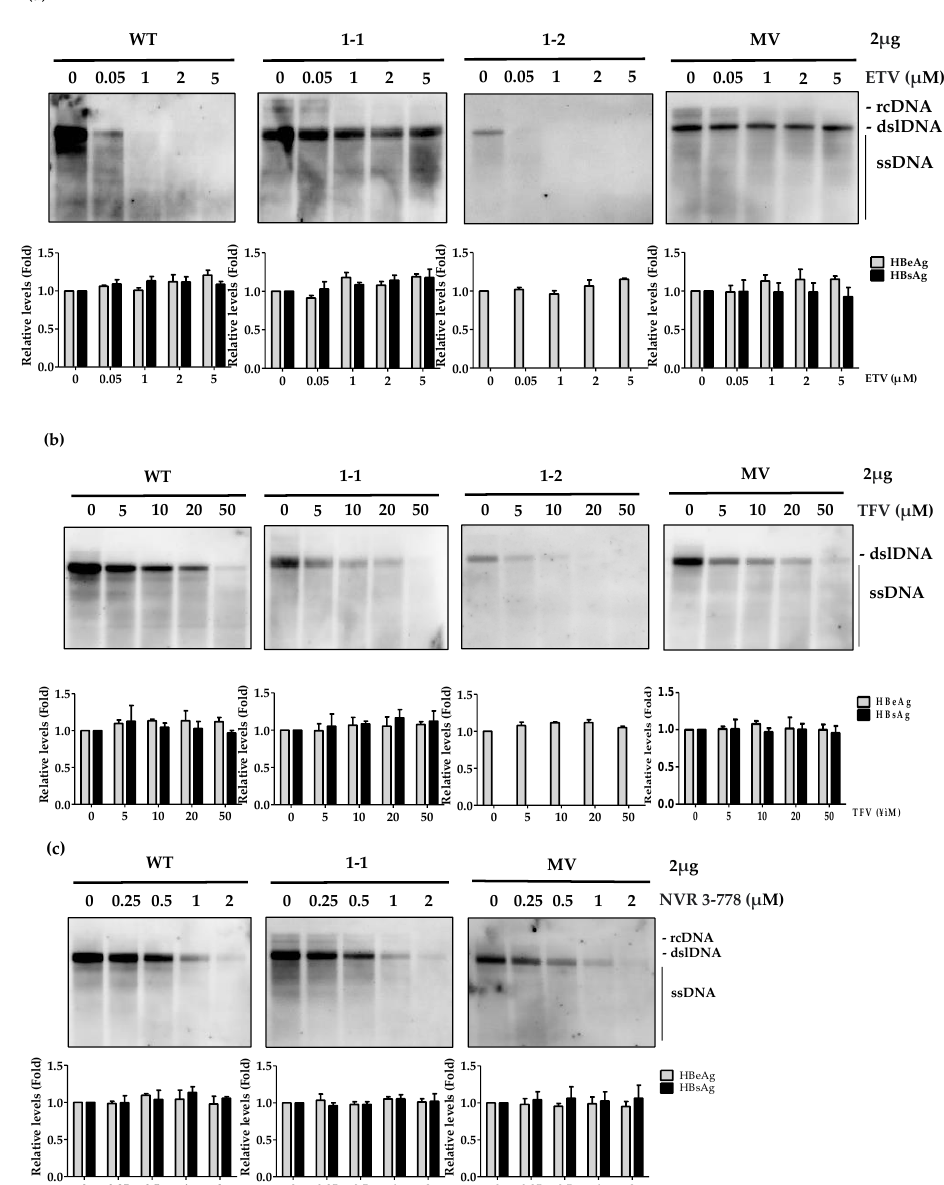
Figure 4. Susceptibility of BFV-resistant mutants to other antiviral drugs. ( a , b ) The in vitro drug susceptibility assay of patient-derived (1-1 and 1-2) and artificial MV clones was performed after treatment with ETV or TFV. After transfection with 2 µg of the indicated HBV 1.2mer mutants into Huh7 cells were treated with indicated antiviral agents (ETV or TFV) for 4 days. HBV replicative capacity was analyzed using Southern blot and detected with a DIG-labeled probe. The secreted HBV antigen levels (HBeAg, HBsAg) were analyzed by ELISA. ( c ) The drug susceptibility assay of patient-derived and artificial MV clones was performed after treatment with capsid assembly inhibitor, NVR 3-778. After transfection with indicated HBV 1.2 mer mutants into Huh7, cells were treated with NVR 3-778 for 4 days. HBV replicative capacity was analyzed using Southern blot.